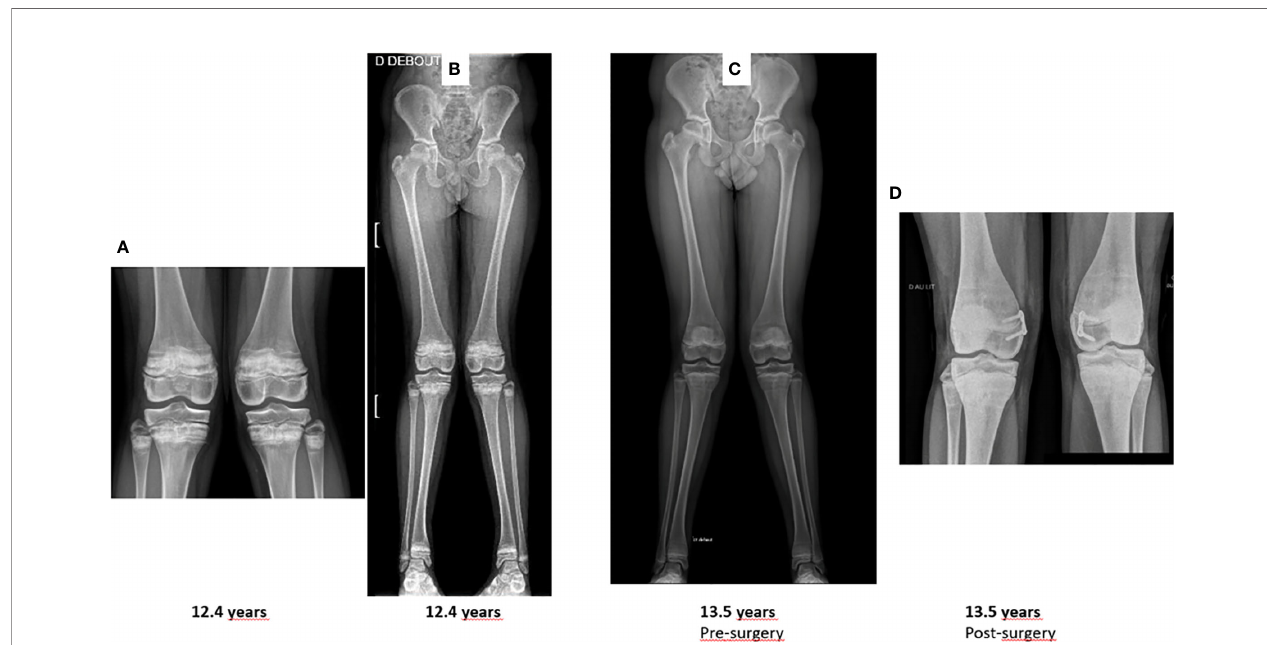
FIGURE 4 | Knees and lower limb radiographs. Lower limbs were imaged standing using EOS. (A, B) lower limb deformities at the age of 12.4 years. (C) deformities worsened after one additional year, (D) post-surgery radiographs of